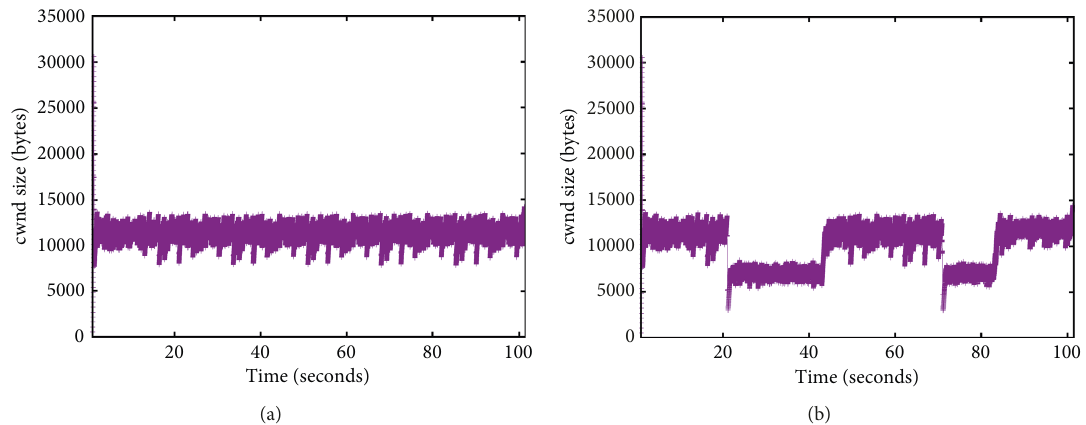
Figure 9: Performance of the ARWA method (b) with burst of data traffic and (a) without burst of data traffic in LTE